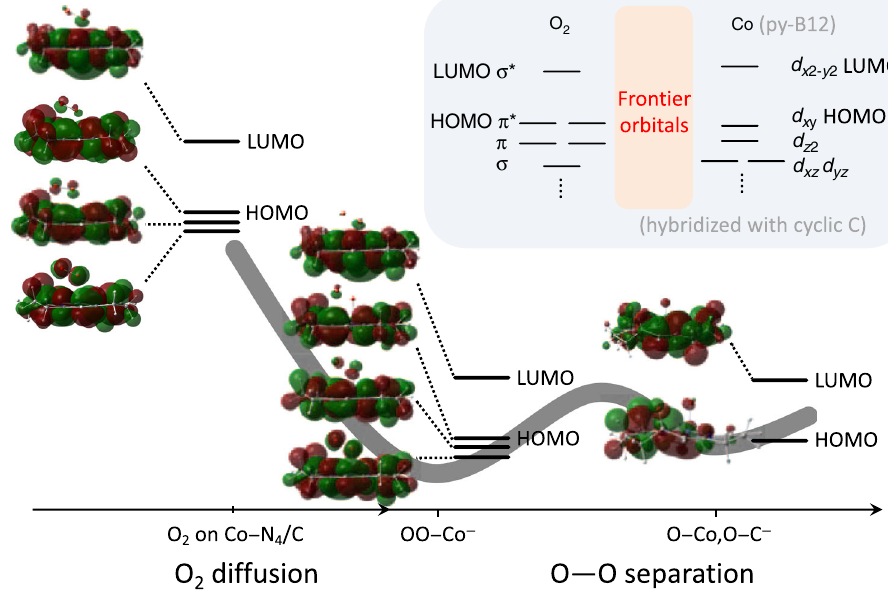
Fig. 4 Molecular orbital description of Co – N 4 /O 2 interaction. Simulated molecular orbital in accordance with the four-electron ORR process. The d 7 electron crystal fi eld orbital and a hybridization orbital, along with the oxygen electron ( σ * and π *) and a schematic model of the Co – N 4 /C – O 2 bond con fi guration. The potential curve is referred to ref. 4